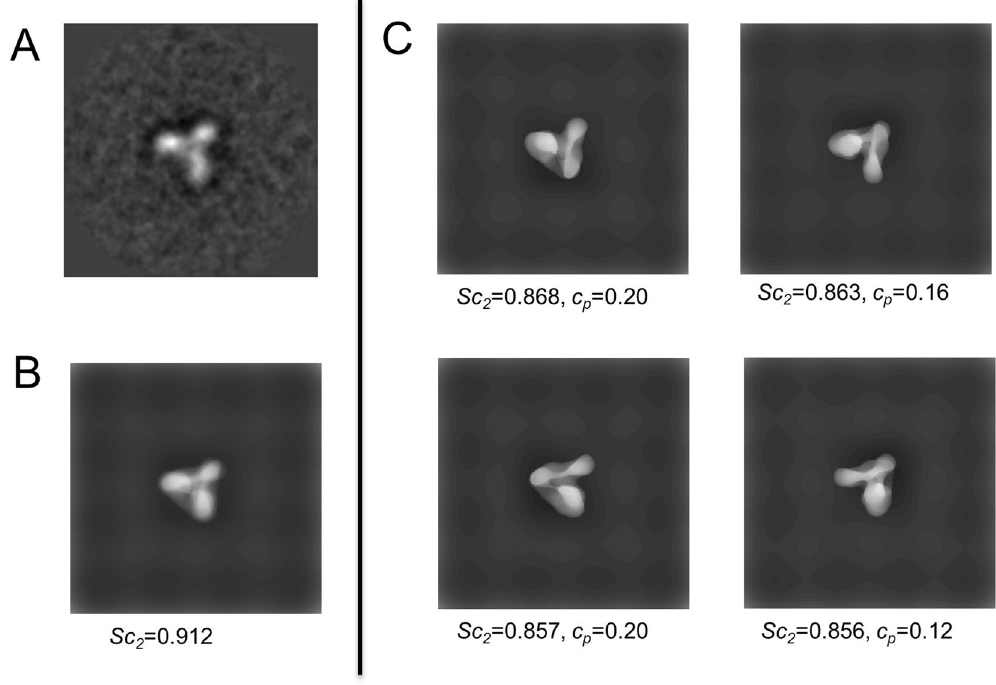
Figure 4. Demonstration of how combination of negative stain models reproduced an EM image well. ( A ) EM image of integrin in Ca 2 + solution (Ca-002 in Supplementary Fig. S1). ( B ) Combined negative stain model. ( C ) Negative stain models of peak conformations used to build the model in ( B ). Only those models with weighting factor c p > 0.1 are shown. Sc 2 and c p are given beneath each negative stain model in ( B , C